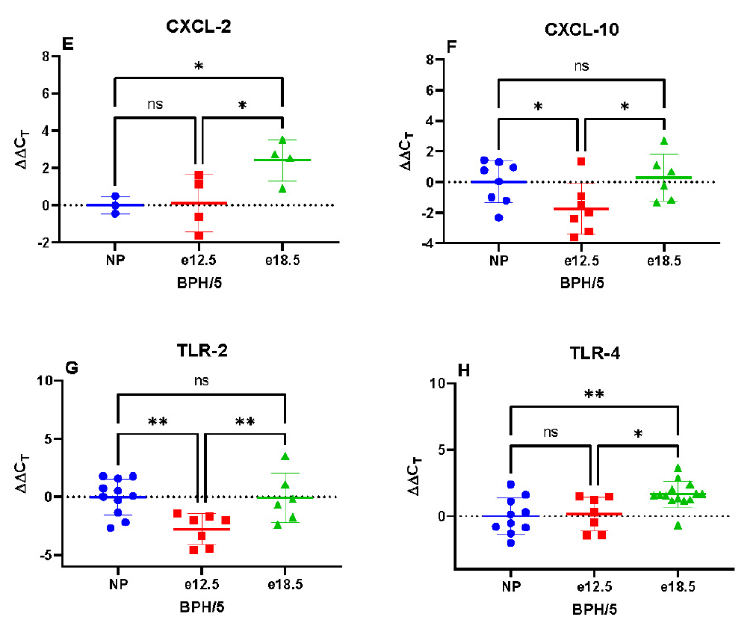
Figure 4. Transcriptional expression of hepatic inflammatory markers in BPH/5 mice preconception and at mid-late gestation ( n = 7–15 per group). ( A ) Pan interferon (IFN) mRNA expression was significantly downregulated at e18.5, ( B ) Interleukin 1-beta (IL-1 β ) was unchanged during gestation, ( C ) Tumor necrosis factor-alpha (TNF α ) expression was upregulated at e12.5, ( D ) C-X-C motif chemokine ligand-1 (CXCL-1) was unchanged during gestation, ( E ) C-X-C motif chemokine ligand-2 (CXCL-2) mRNA expression was significantly downregulated at e18.5, ( F ) C-X-C motif chemokine ligand-10 (CXCL-10) mRNA expression was significantly upregulated at e12.5, ( G ) Toll-like receptor-2 (TLR-2) transcription was significantly upregulated at e12.5, ( H ) Toll-like receptor-4 (TLR-4) expression was significantly downregulated at e18.5. * p < 0.05, ** p < 0.01, **** p < 0.0001 ns, not significant.